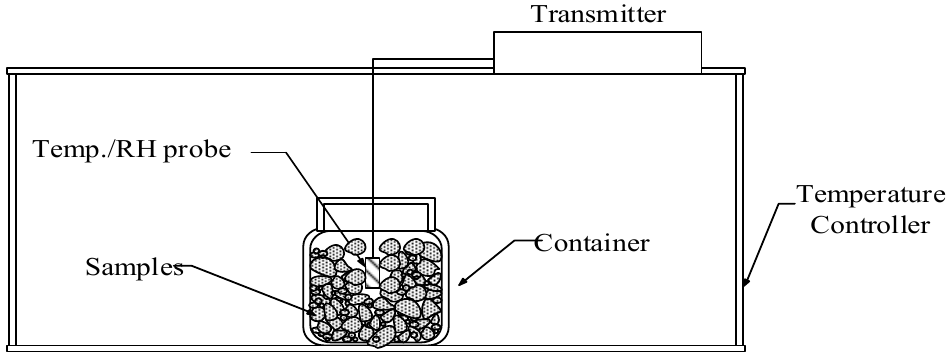
Figure 1. Sketch of experimental set-up.